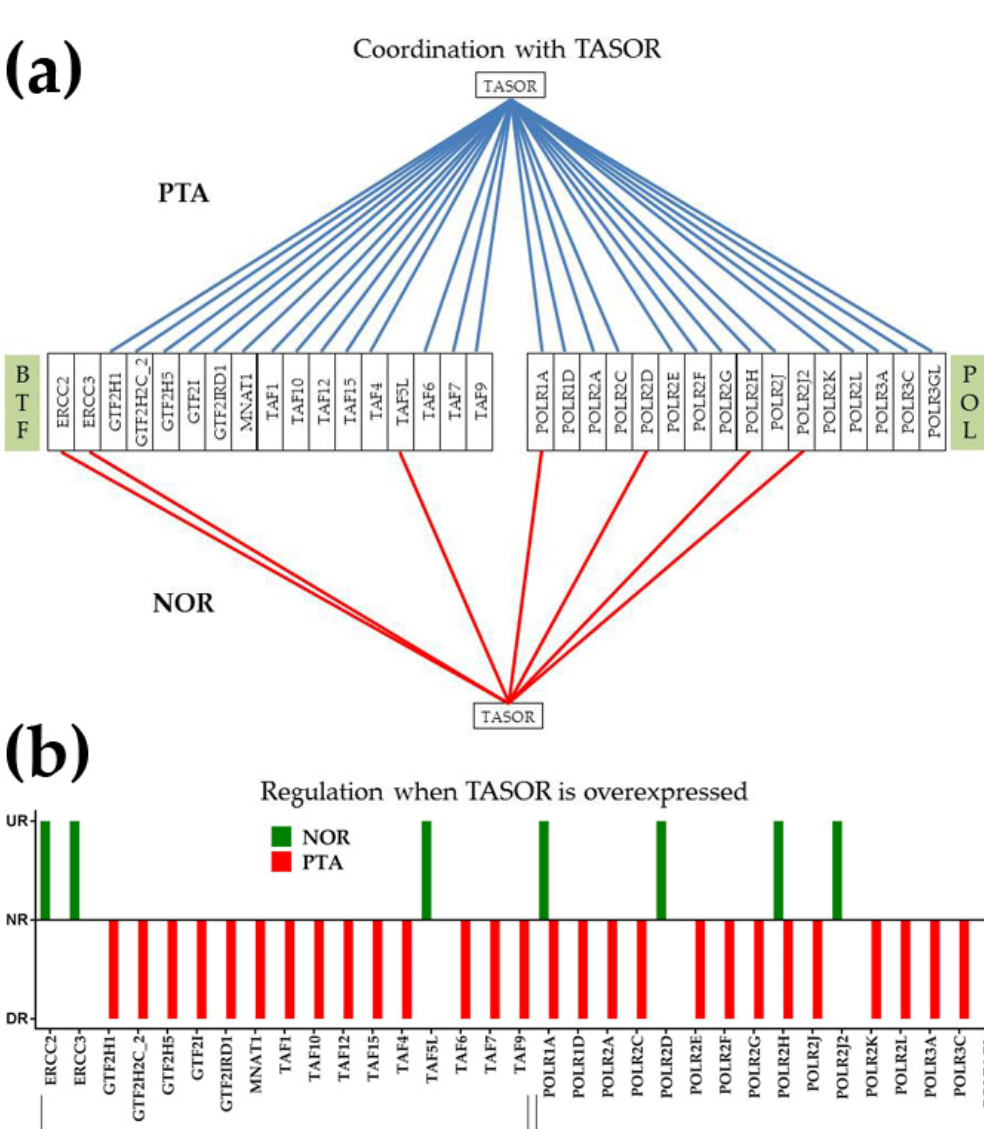
Figure 7. Possible molecular mechanism by which over expression of TASOR would selectively destroy the PTA cells. ( a ) Expression correlation of TASOR with basal transcription factors (BTF) and RNA polymerase pathway (POL) genes in PTA and NOR. A red/blue line indicates synergistic/antagonistic expression, respectively. Missing line indicates a non-significant correlation. ( b ) Possible effects of TASOR overexpression on the basal transcription factors and RNA polymerase pathway genes. UR = upregulated, NR = not regulated, DR = downregulated. In CWM, the GMR ALG13 was synergistically expressed with 33 (38%) and antagonistically expressed with 3 (3%) of the 88 quantified KEGG-determined cell cycle (CC) genes [63], while in NOR, 3 (3%) were synergistically and 4 (5%) antagonistically expressed with ALG13 (Figure 8a).